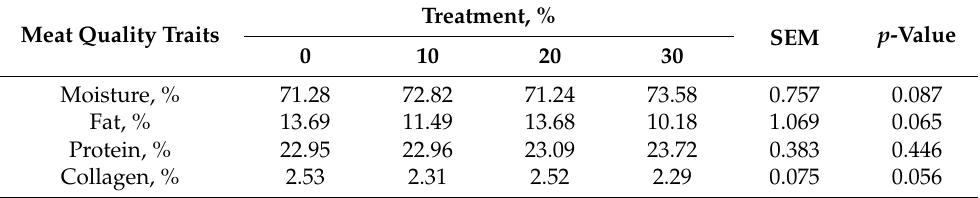
Table 4. Physio-chemical attributes of goat meats supplemented with varying levels of HSM. Meat Quality